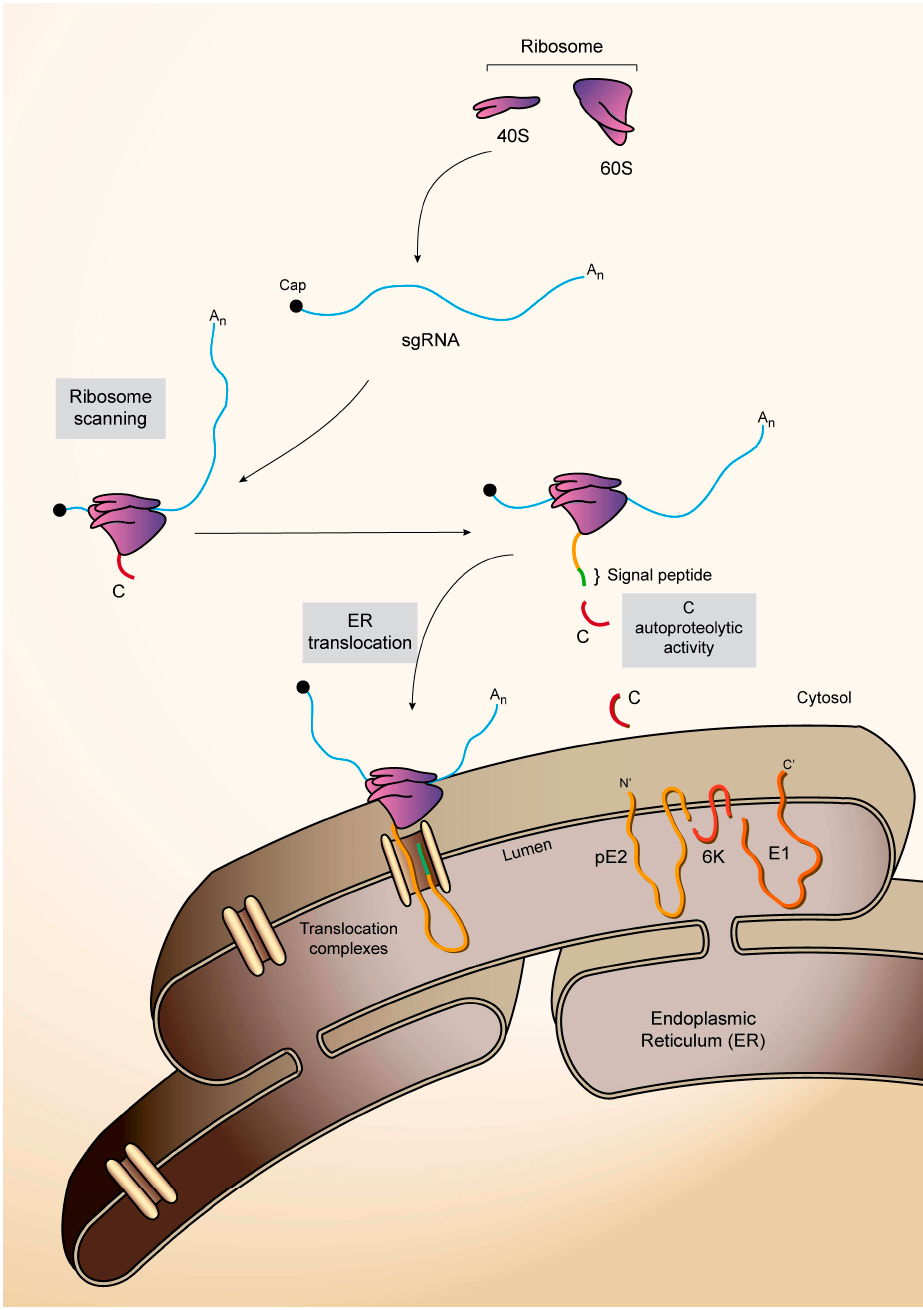
Figure 2. Schematic representation of SINV sgRNA translation to render structural proteins C (capsid)-E3-E2-6K-E1. The sgRNA coding sequence is flanked by two untranslated regions (UTRs): 5 (cid:48) -UTR, which contains a cap structure at its 5 (cid:48) end, and 3 (cid:48) -UTR, which ends in a poly-(A)